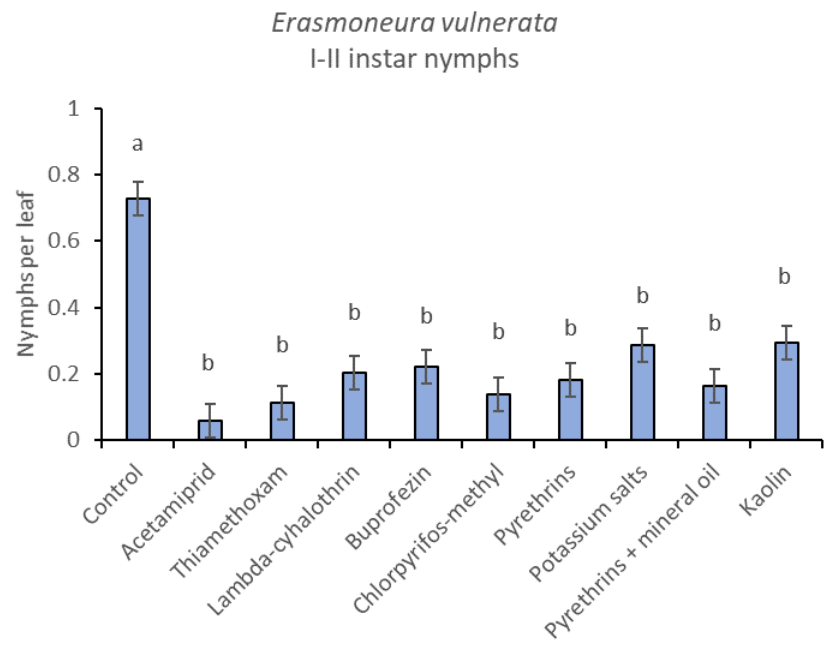
Figure 4. Least-square means ( ± std. err.) of Erasmoneura vulnerata early (I-II instar) nymphs observed on different treatments in the 2017 trial. Different letters indicate significant differences at t -test ( α = 0.05.).